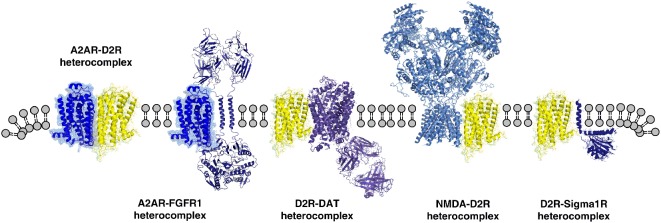
Illustration of the diversity of heteroreceptor complexes that are formed between different families of receptors in the plasma membrane shown as heterodimers. The A2AR-D2R heterodimer is shown as an example GPCR-GPCR heteromers (Borroto-Escuela et al., 2013c, 2018b,d). The A2AR-FGFR1 heterodimer (Flajolet et al., 2008; Borroto-Escuela et al., 2013b) is shown as an example of GPCR-RTK heteromers. The D2R-N-Methyl-D-aspartate (NMDA) heterodimer (Liu et al., 2006) is shown as an example of GPCR-ionotropic receptor heteromers. D2R-dopamine transporter (DAT) complex (Lee et al., 2007) is shown as an example of GPCR-monoamine transporter complexes. The D2R-Sigma1 receptor heterodimer is shown as an example of GPCR-single spanning transmembrane receptor heteromer (Pinton et al., 2015b; Borroto-Escuela et al., 2016a, 2017b).